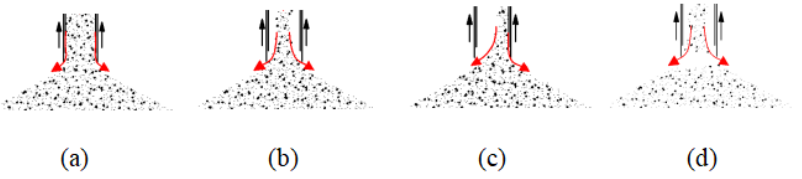
Figure 8. Coking coal discharge status at bottom of cylinder. ( a ) Dense phase flow phenomenon; ( b – d ) Dilute phase flow phenomenon